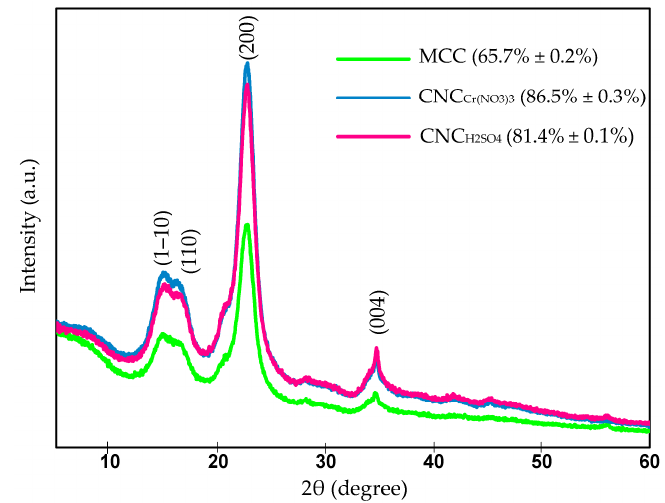
Figure 2. X-ray diffraction (XRD) patterns of the native cellulose, CNC H2SO4 and CNC Cr(NO3)3 . The parenthesis refers to the crystallinity index of the samples.